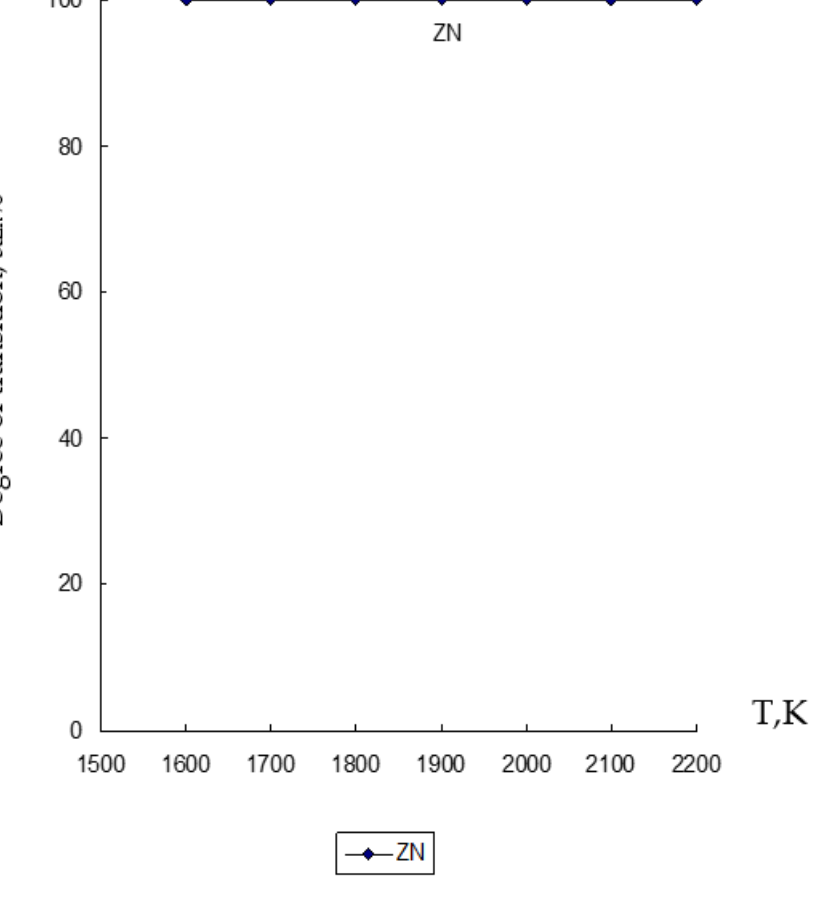
Figure 2. Influence of temperature (T) on the degree of distribution ( α ) of Zn in the ZnO · SiO 2 - FeO · Fe 2 O 3 -C system.